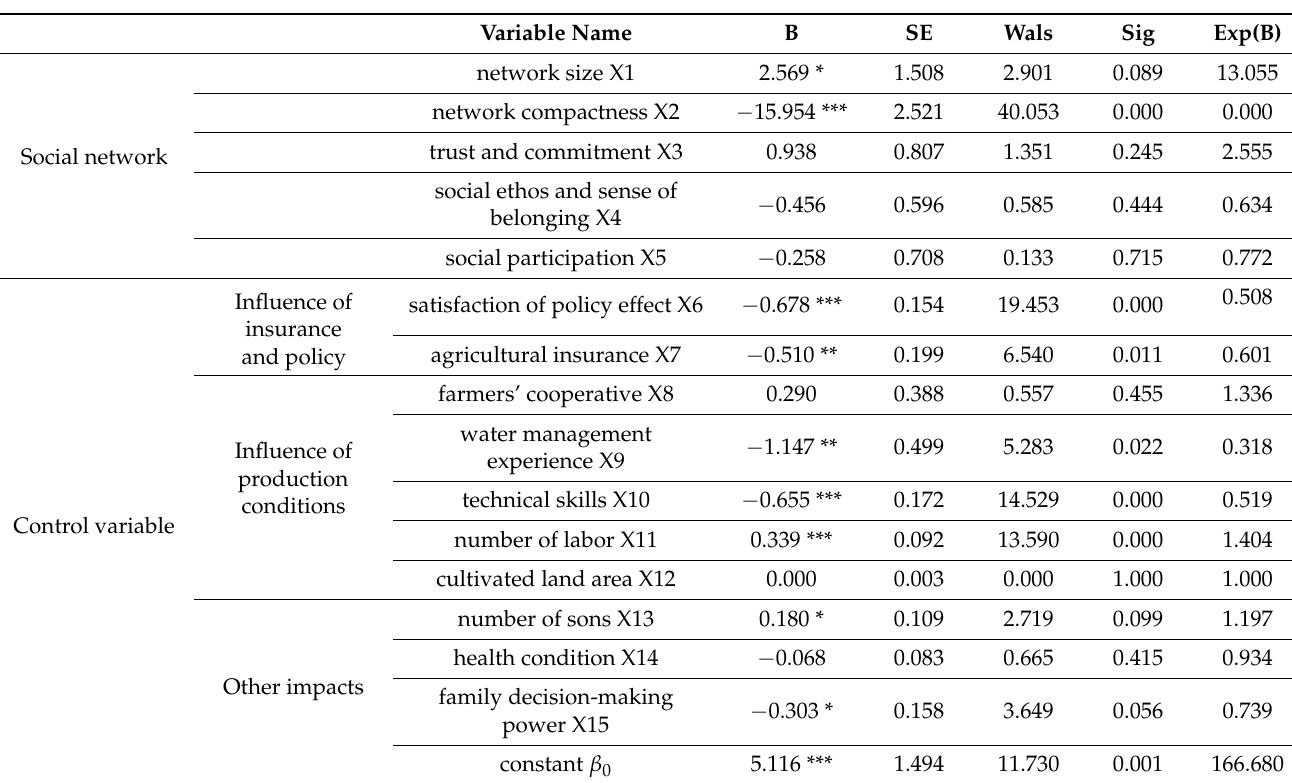
Table 3. The regression results of driving factors of social network